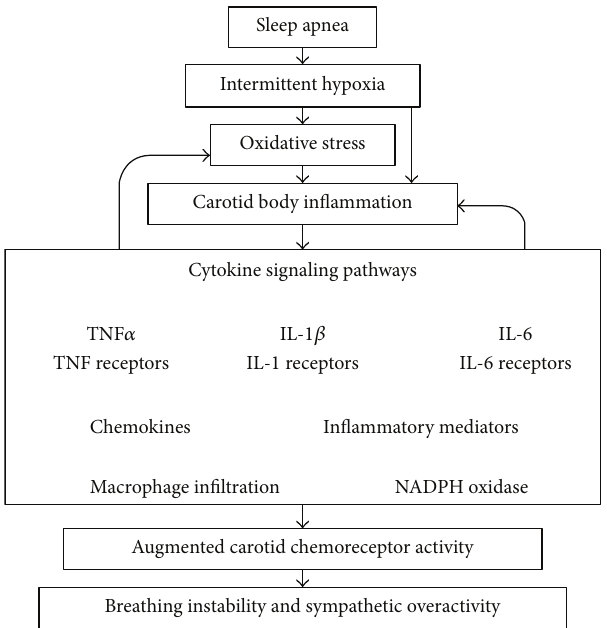
Figure 1: Schematic diagram shows the role of inflammation in the carotid body in the pathogenic cascade of sleep apnea. Arrows are the direction of the pathogenic effects of oxidative stress and inflammation in the carotid body leading to augmented activities of the carotid chemoreceptor and chemoreflex activity, significantly contributing to the pathophysiological consequence impacting on breathing instability and autonomic